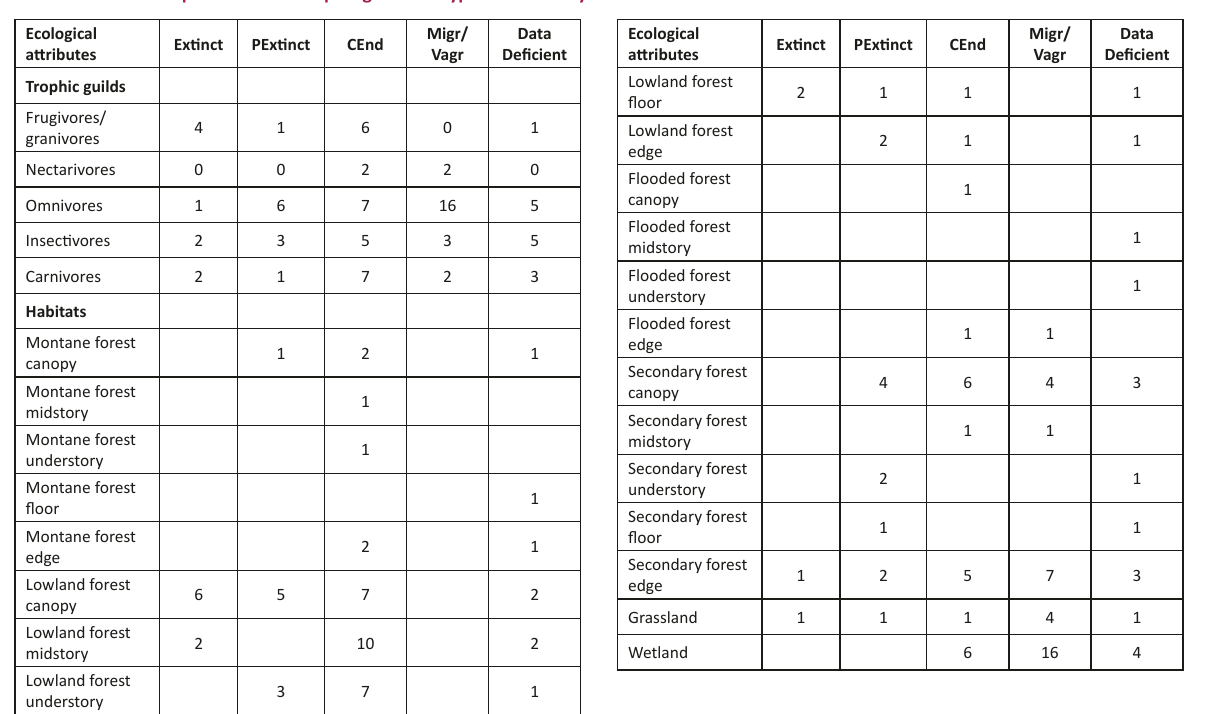
(Table 3). Thirteen endemic Atlantic forest birds were considered locally Extinct (2 species), Probably Extinct (three species) or Critically Endangered (eight species). Among the Naturally Rare Migrant or Vagrants in the state of Rio de Janeiro, the majority were omnivorous species (66.6%) inhabiting wetlands (62.5%). Thirteen birds were considered insufficiently known in Rio de Janeiro, so classified as Data Deficient species.